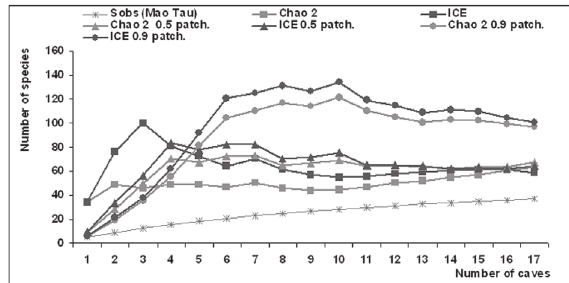
Figure 4 - Rarefaction curves of observed copepod species rich- ness and estimates for Pădurea Craiului Mountains based on the cumulated data from all five caves (UC, VC, LC, CC, DC) and from the database (37 species, 17